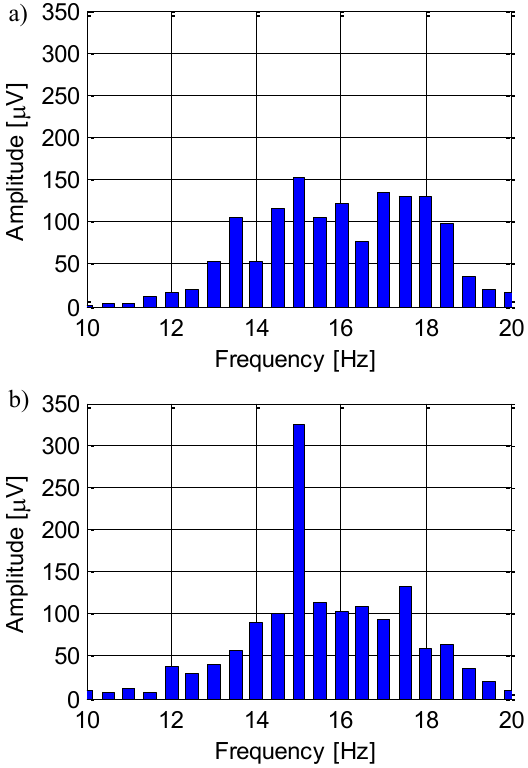
Fig. 3. Classification of hybrid BCIs [7].